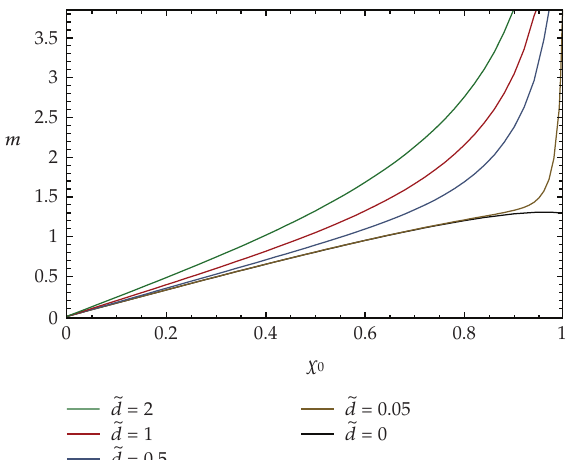
Figure 7: Dependence of the quark mass parameter m on the initial value χ 0 of the embedding.